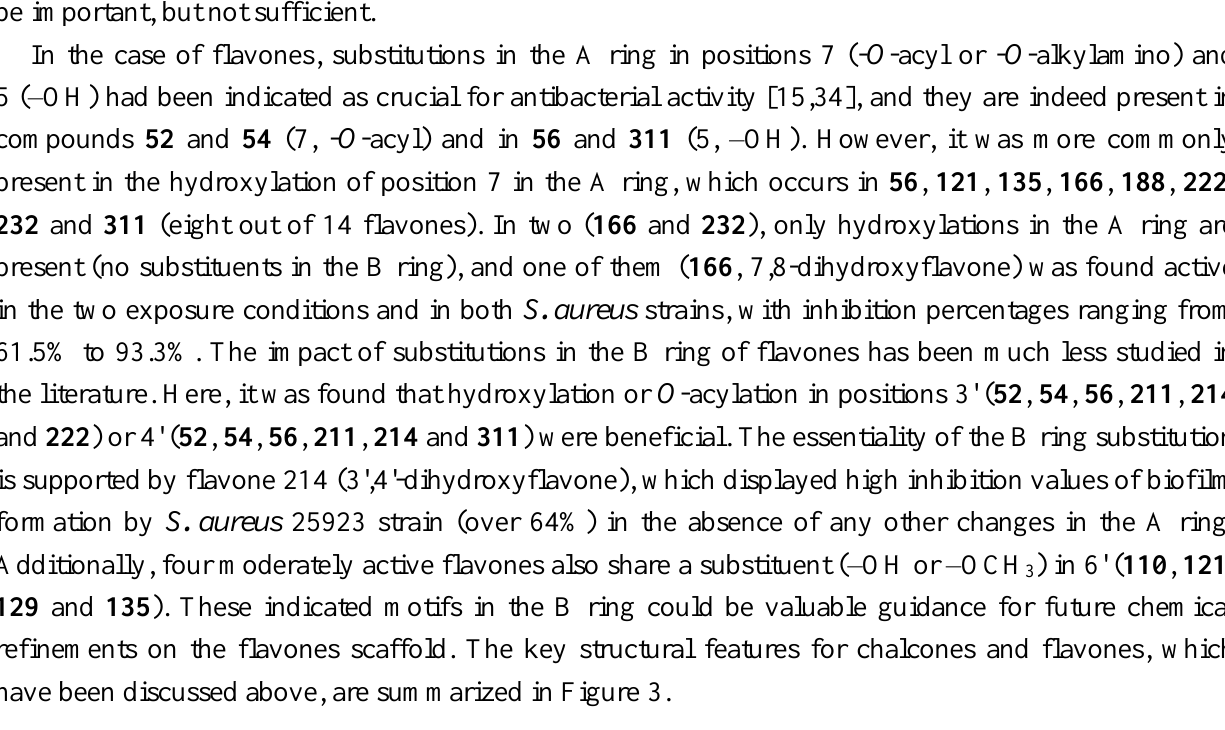
Figure 3. Key structural features present in the anti-biofilm chalcones and flavones (moderately and highly active